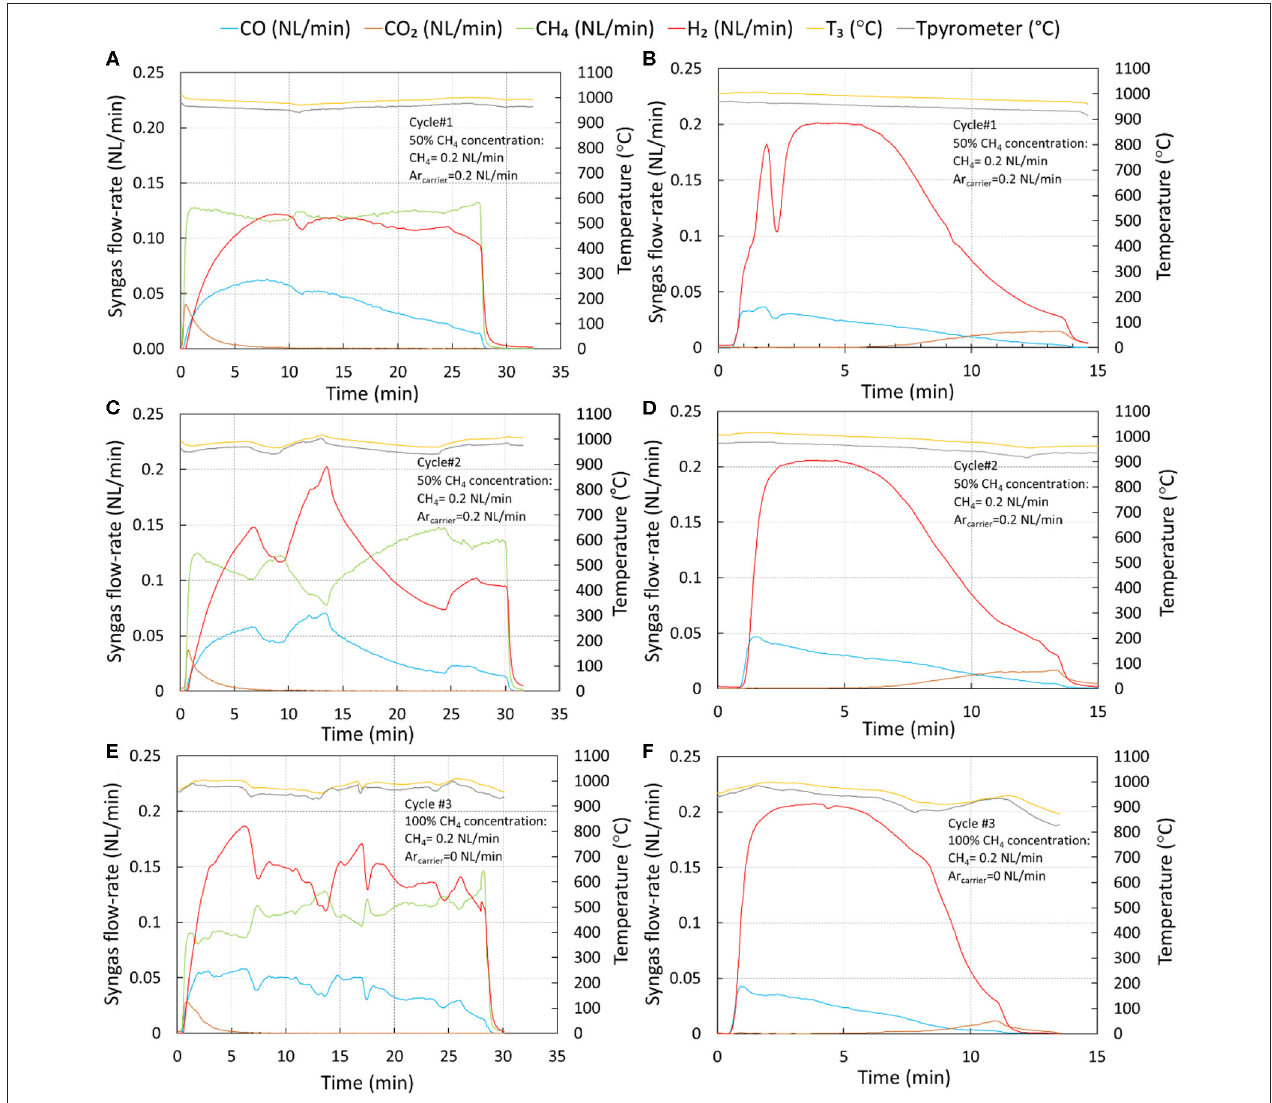
FIGURE 6 | Syngas production rates and reactor temperatures ( T 3 and T pyrometer ) during (A,C,E) ceria reduction with CH 4 and (B,D,F) reduced ceria oxidation with H 2 O for three cycles with different CH 4 concentrations of 50 and 100% at 1,000 ◦